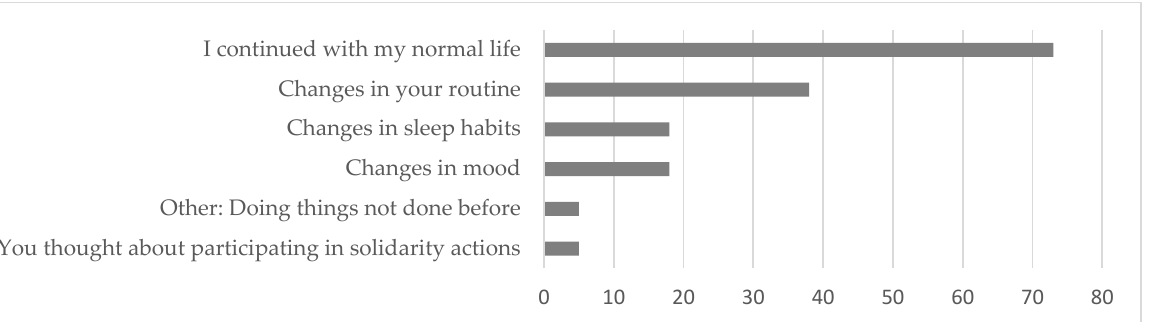
Figure 5. Impact of the pandemic on the daily life of people with AD.